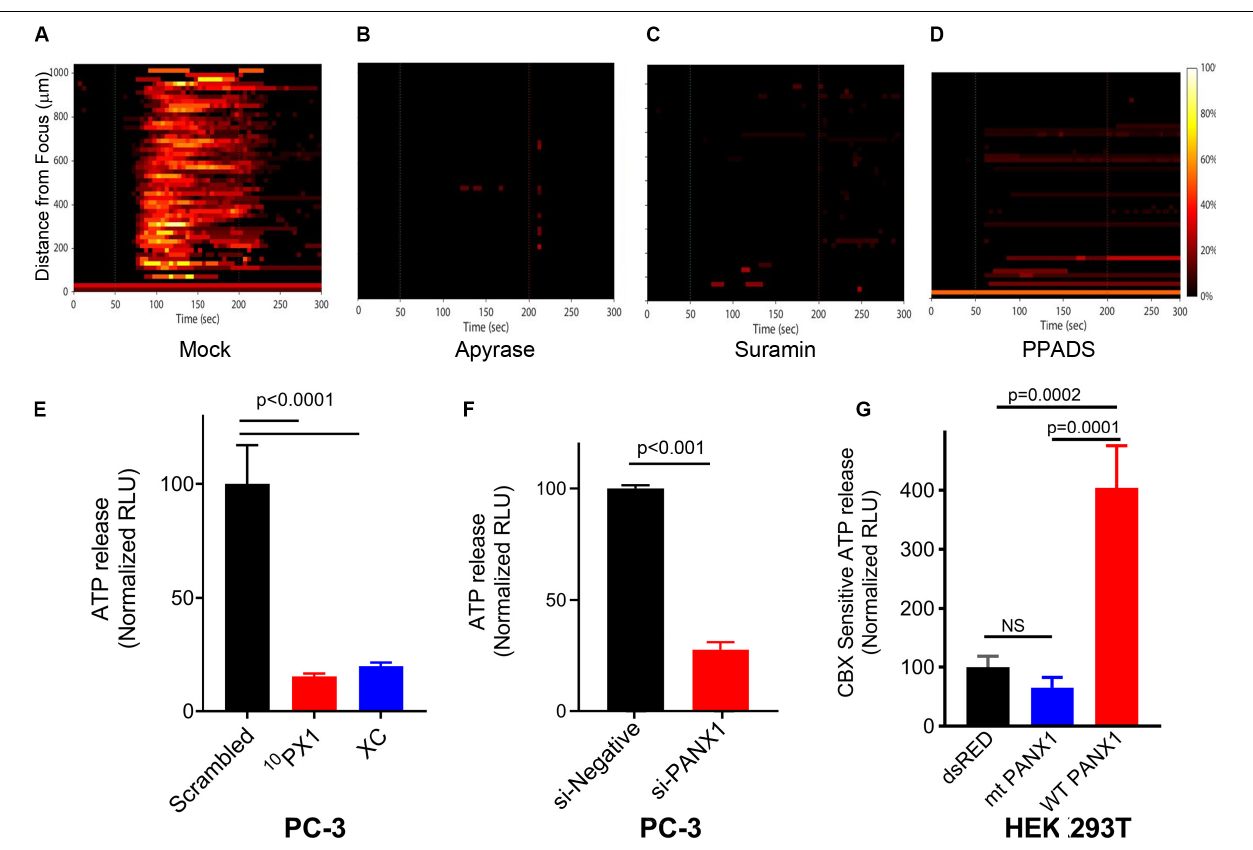
FIGURE 7 | Effects of intercellular Ca 2 + wave inhibitors on Ca 2 + response (A–D) , and effects of PANX1 modulation on ATP release (E–G) . The responses are represented when PC-3 cells were treated with Apyrase, Suramin, PPADS and mock; Mock (A) , 20–50 units/ml Apyrase (B) , 100 µ M Suramin (C) , and 100 µ M PPADS (D) . The percentage of responding cells over time was shown. Experimental results presented are representative and were independently replicates at least two times with three independent biological samples. (E) Quantification of PANX1-mediated ATP release from PC-3 cells pretreated for 15 min with scrambled (SC), 10 PX1, or Xestospongin C (XC). n = 4. ANOVA, Dunnet’s correction, exact p -values. (F) Quantification of PANX1-mediated ATP release from PC-3 cells transfected with control si-negative or si-PANX1 RNA. n = 4, p -values by a two-tailed t -test. (G) Quantification of PANX1-mediated ATP release from HEK cells transfected with dsRED, mt PANX1-mRFP or WT PANX1-EGFP, and pretreated for 10 min with CBX (500 µ M). n = 3. ANOVA, Dunnet’s correction, exact p -values. Error bars, s.e.m., NS, not